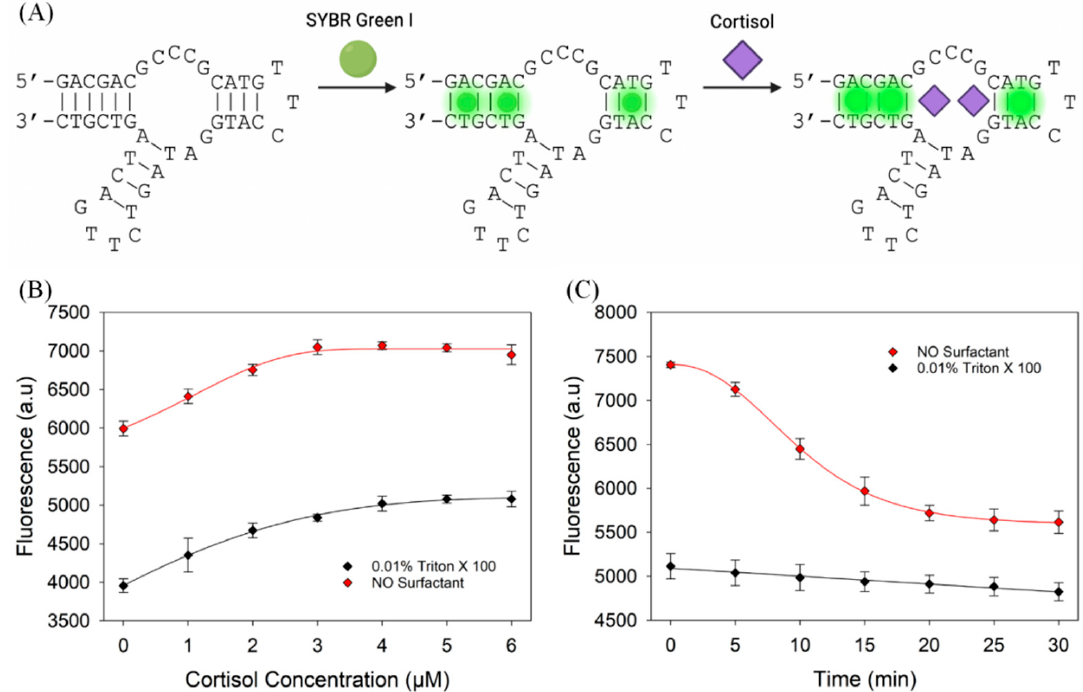
Figure 6. ( A ) The scheme of cortisol binding to its aptamer detected by SYBR Green I. Initially, the combination of SGI and aptamer produces weak fluorescence, and after the addition of cortisol, aptamer–cortisol binding results in enhanced fluorescence. ( B ) Titration curve of 1 µ M CSS.1-42 with cortisol with and without Triton X-100. ( C ) Effect of Triton X-100 on signal stability of CSS.1-42 Apt-SGI-cortisol